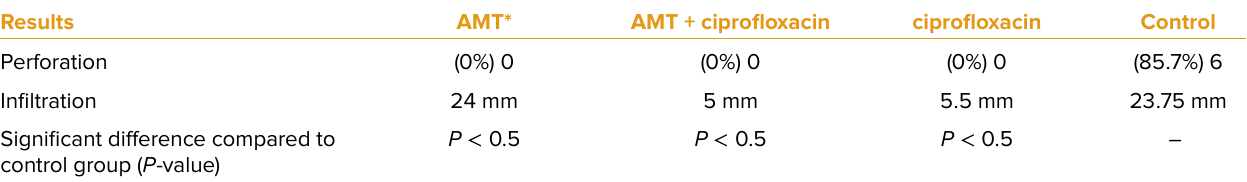
Table 2. Clinical outcomes of perforation and infiltration in all four groups of Pseudomonas keratitis